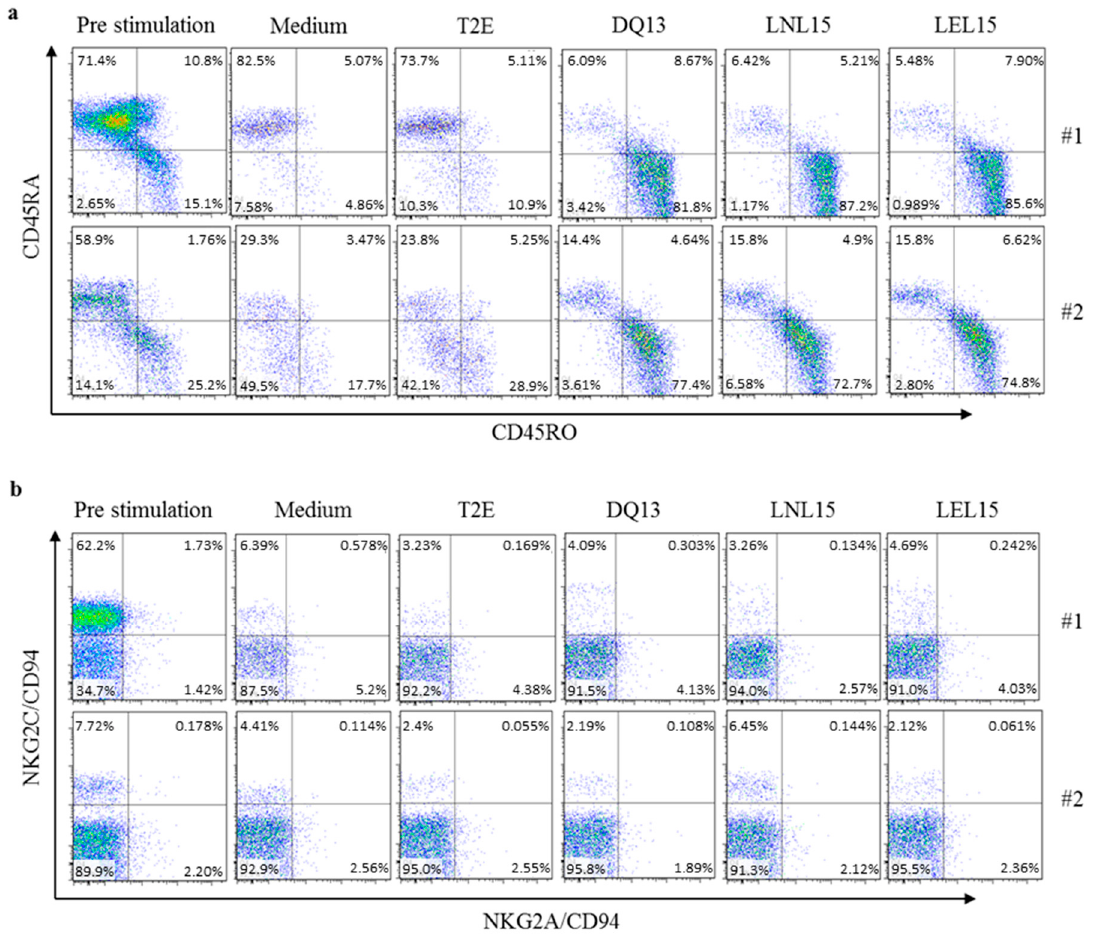
Figure 4. Surface phenotype of HLA-E restricted CD8 + T cells. CD8 + T cells that proliferated in response to distinct p:HLA-E complexes on T2E cells were assessed for ( a ) the surface expression of CD45RA or CD45RO and ( b ) the expression of NKG2A/CD94 or NKG2C/CD94 receptors after 10 days of stimulation via flow cytometry. Pre stimulation (day 0), incubation with cell medium only and incubation with T2E cells without peptide are displayed as controls. Shown are results from PBMCs from two different individuals (#1, #2).